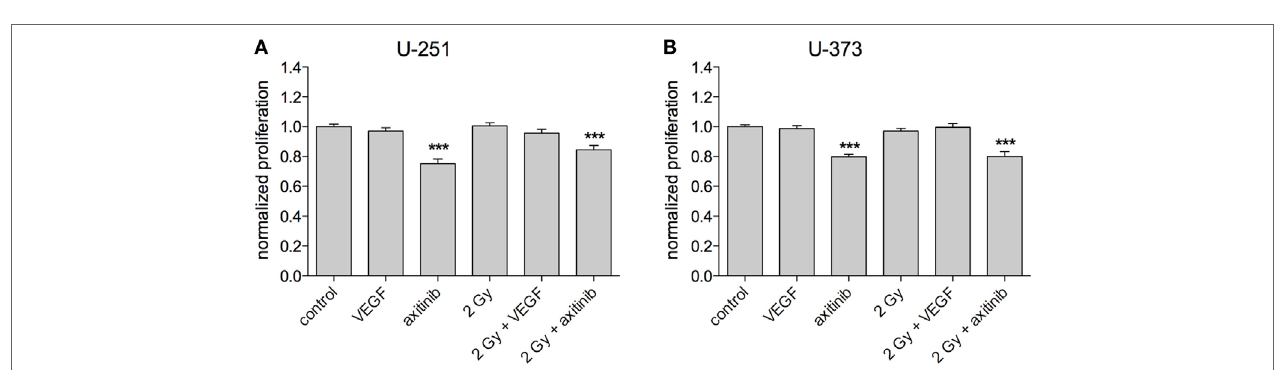
FigUre 3 | Influence of vascular endothelial growth factor (VEGF), axitinib, or irradiation with 2 Gy photons on the proliferation of glioblastoma multiforme cell lines U-251 and U-373. (a,B) Axitinib impairs the proliferation of irradiated and non-irradiated U-251 and U-373 cells. VEGF, irradiation, or the combination of both has no significant effect on cell proliferation. The proliferation of the cells was analyzed by a modified MTS-test. VEGF and axitinib were added in concentrations of 0.1 and 10 µg/ml, respectively. Data are shown as mean ± SEM. Data were tested for significance using one-way ANOVA with Bonferroni multiple comparison post-test. Significant differences are indicated by *** p < 0.001.